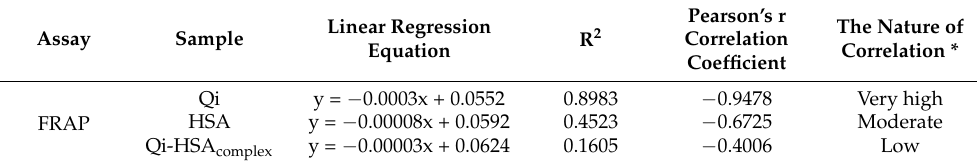
Table 9. Pearson’s r correlation coefficient—FRAP assay. Pearson’s r Linear Regression The Nature of Assay Sample Correlation R 2 Equation Correlation * Coefficient Qi y = − 0.0003x + 0.0552 0.8983 − 0.9478 Very high HSA y = − 0.00008x + 0.0592 0.4523 − 0.6725 Moderate FRAP Qi-HSA complex y = − 0.00003x + 0.0624 0.1605 −